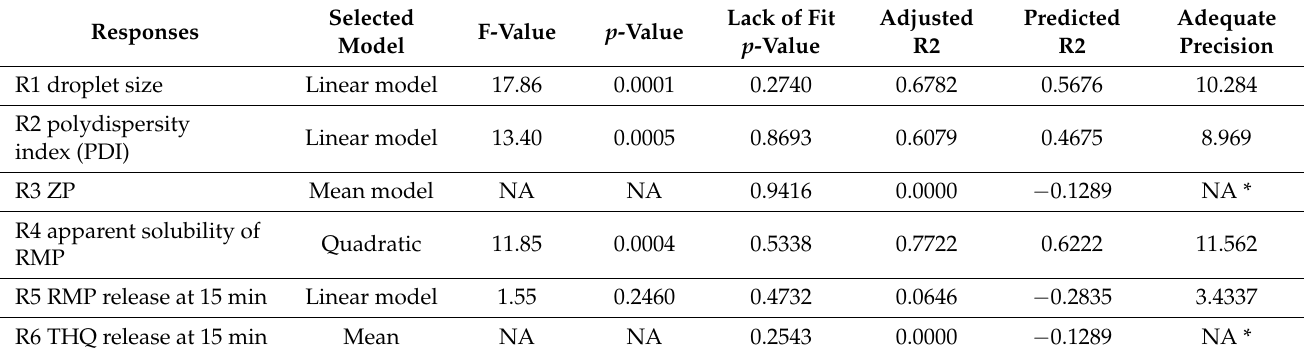
Table 3. ANOVA analysis of the measured responses for the selected